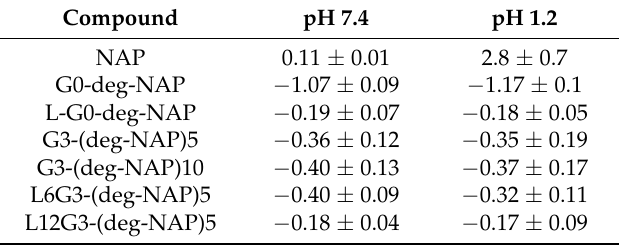
Table 2. The log K app(o/w) (pH 7.4 and pH 1.2) values of naproxen and its conjugates at 37 ◦ C.